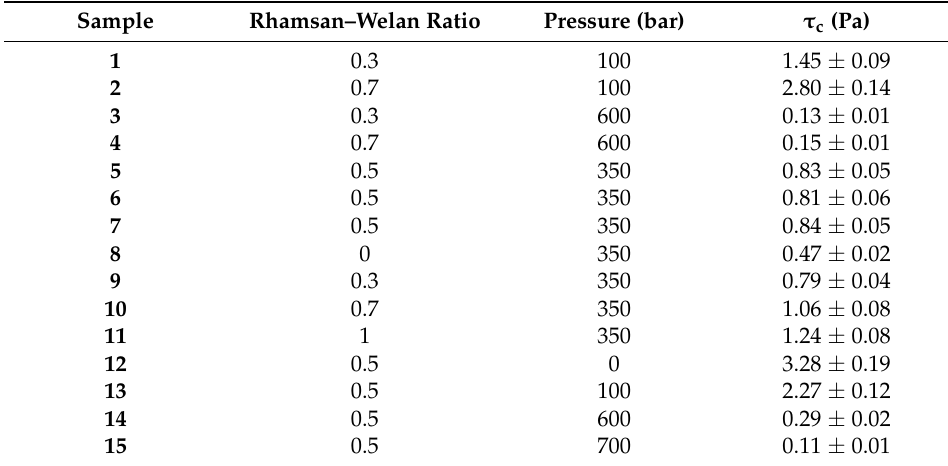
Table 2. Critical shear stress obtained from stress sweeps for the continuous phases studied. Sample Rhamsan–Welan